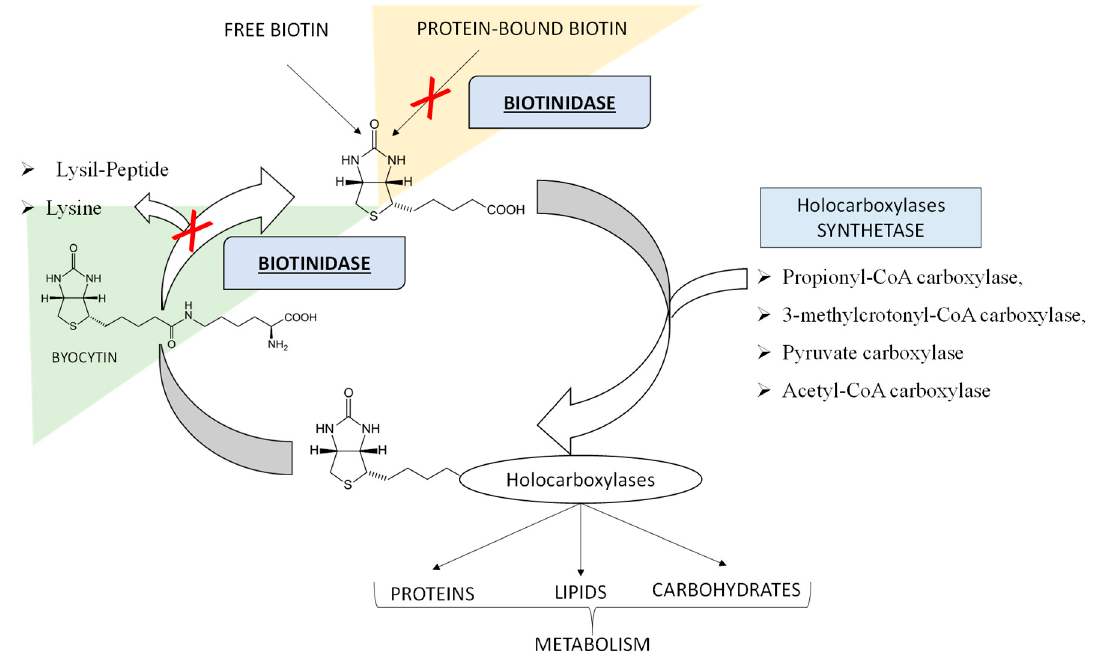
Figure 1. The Biotin Cycle. The figure shows the function of the Biotinidase (BTD) enzyme in making available the waters-soluble vitamin biotin from biocytin and from dietary sources. BTD substrates can be ex novo protein-bound biotin, outside the biotin cycle (as underlined by the orange background) or biocytin resulting from the biotin re-cycle (as underlined by the light green background). In the case of BTD deficiency, as indicated by the red “X”, free biotin, being deficient, cannot properly play its role of coenzyme for the four holocarboxylases, leading to the accumulation of substrates, which causes toxicity and disease signs and symptoms.